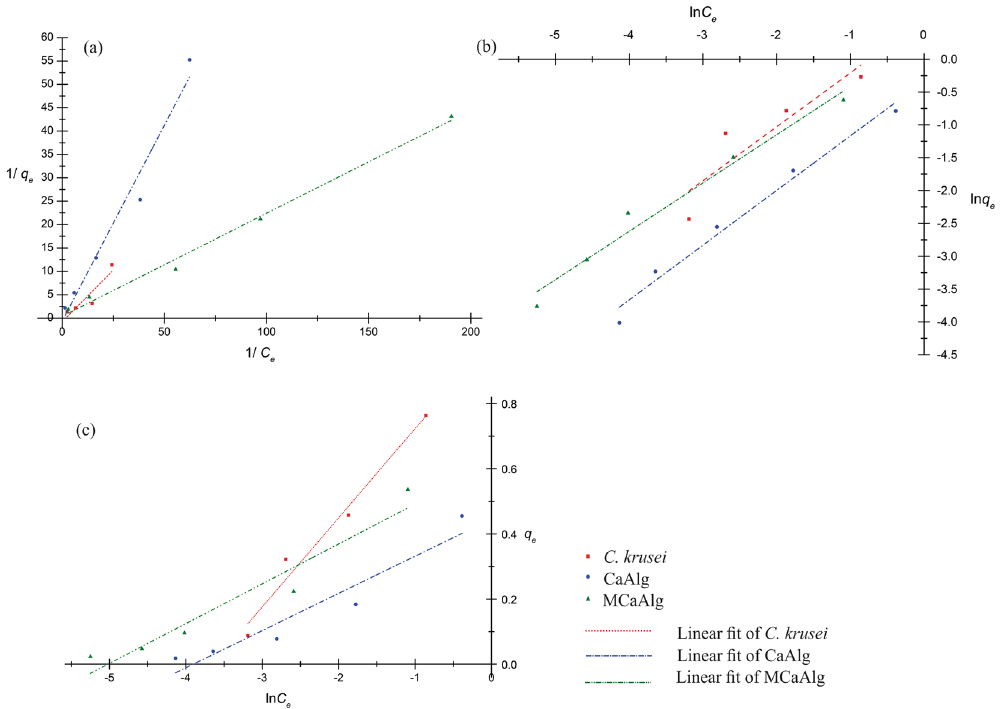
Figure 6. Isotherm modelling on copper(II) removal ( a ) C . krusei , CaAlg and MCaAlg fit in Langmuir isotherm ( b ) C . krusei , CaAlg and MCaAlg fit in Freundlich isotherm. ( c ) C . krusei , CaAlg and MCaAlg fit in Temkin isotherm.